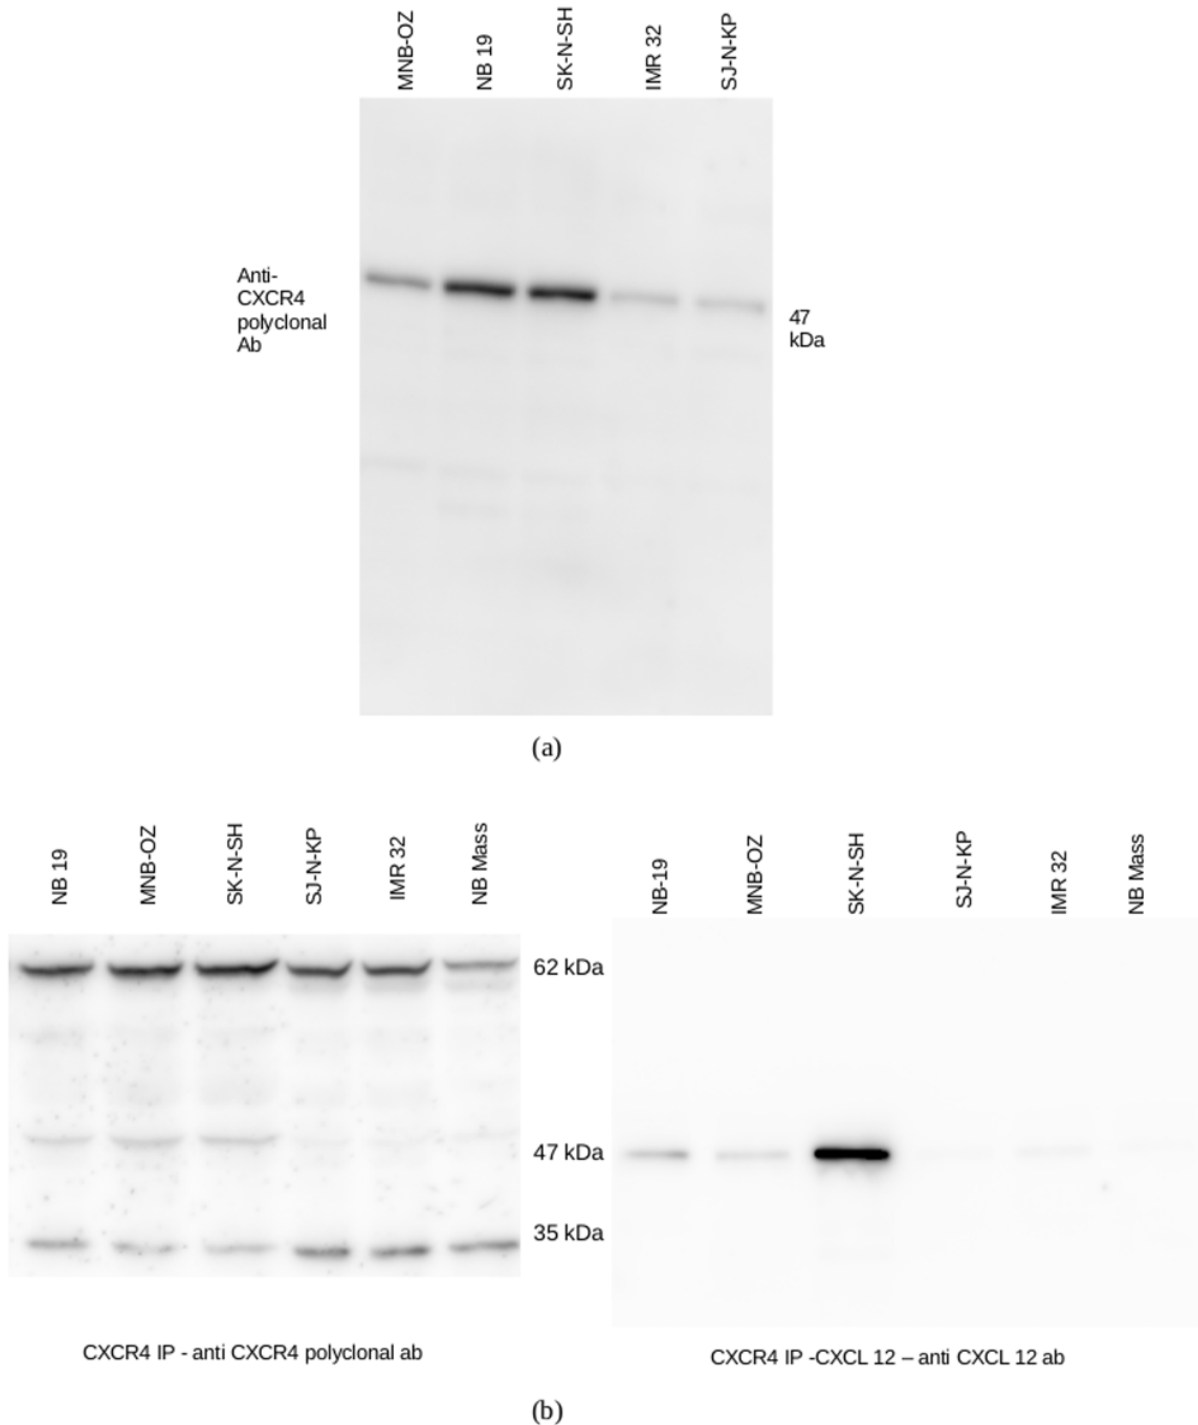
Fig 4. Localization and CXCL12 reactivity of CXCR4. a. The membrane proteins from 3 highly invasive neuroblastoma cell lines, MNB-OZ, NB 19 and SK- N-SH, and 2 less invasive cell lines, IMR 32 and SJ-N-KP were extracted, electrophoresed and blotted on to PVDF membrane. Protein detection was carried out using an anti-CXCR4 polyclonal antibody. Shown in figure is the representative result from 5 experiments. b. CXCR4 immune-precipiate from 3 highly invasive (NB 19, MNB-OZ & SK-N-SH) and 3 less invasive (SJ-N-KP, IMR 32 & NB Mass) cell lines were electrophoresed and blotted on to PVDF membrane. The membrane was incubated overnight with human CXCL12 in TBS-T at 4°C. The blot was washed and protein detection was carried out with anti-CXCL12 antibody. Shown in figure is the representative result from 3 experiments.